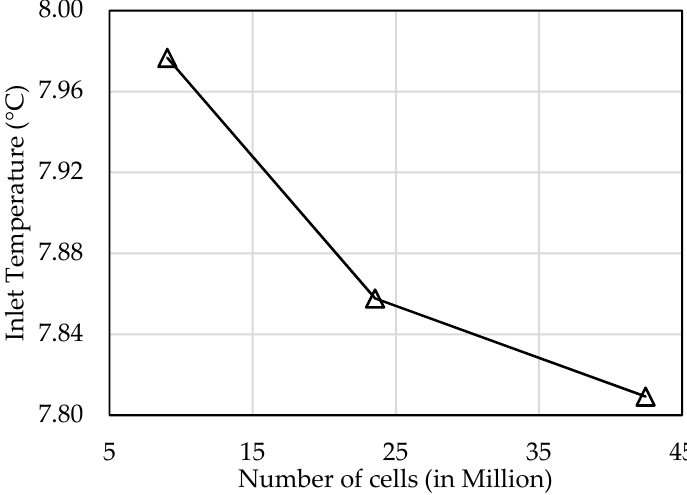
Figure 5. Evolution of inlet temperature as a function of mesh size.